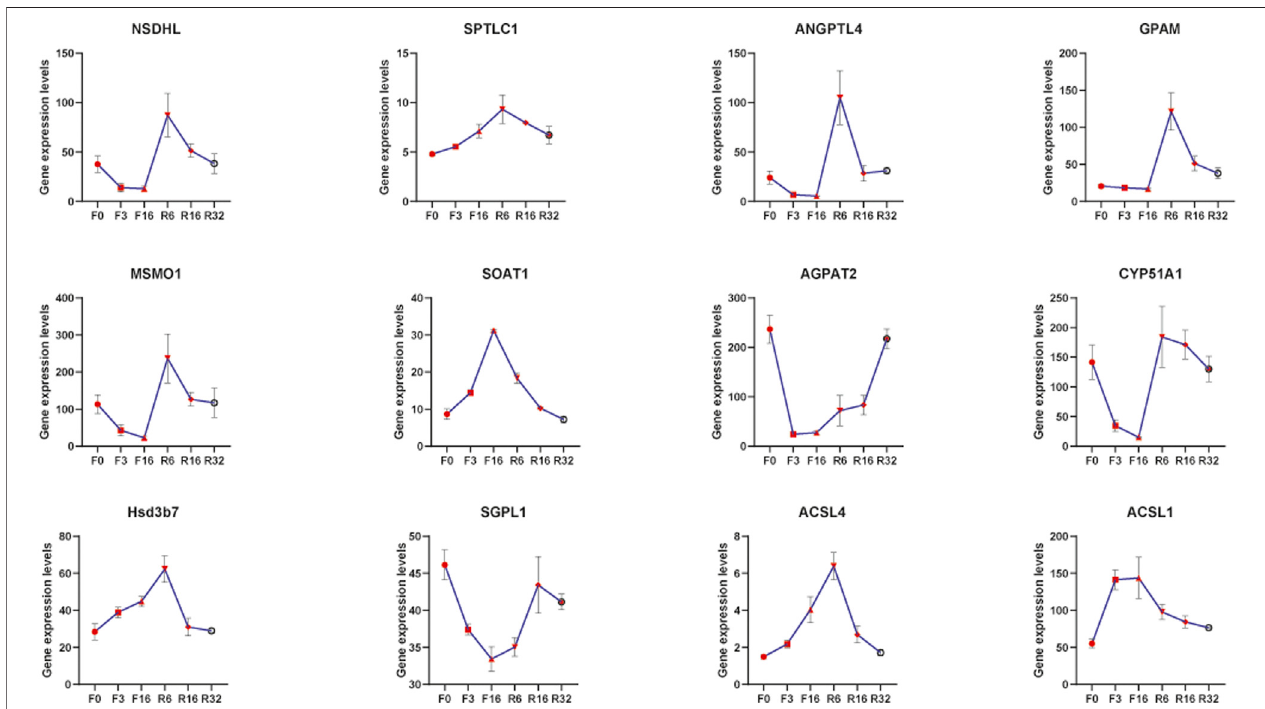
FIGURE 5 | Expression trends of genes related to lipid metabolism during